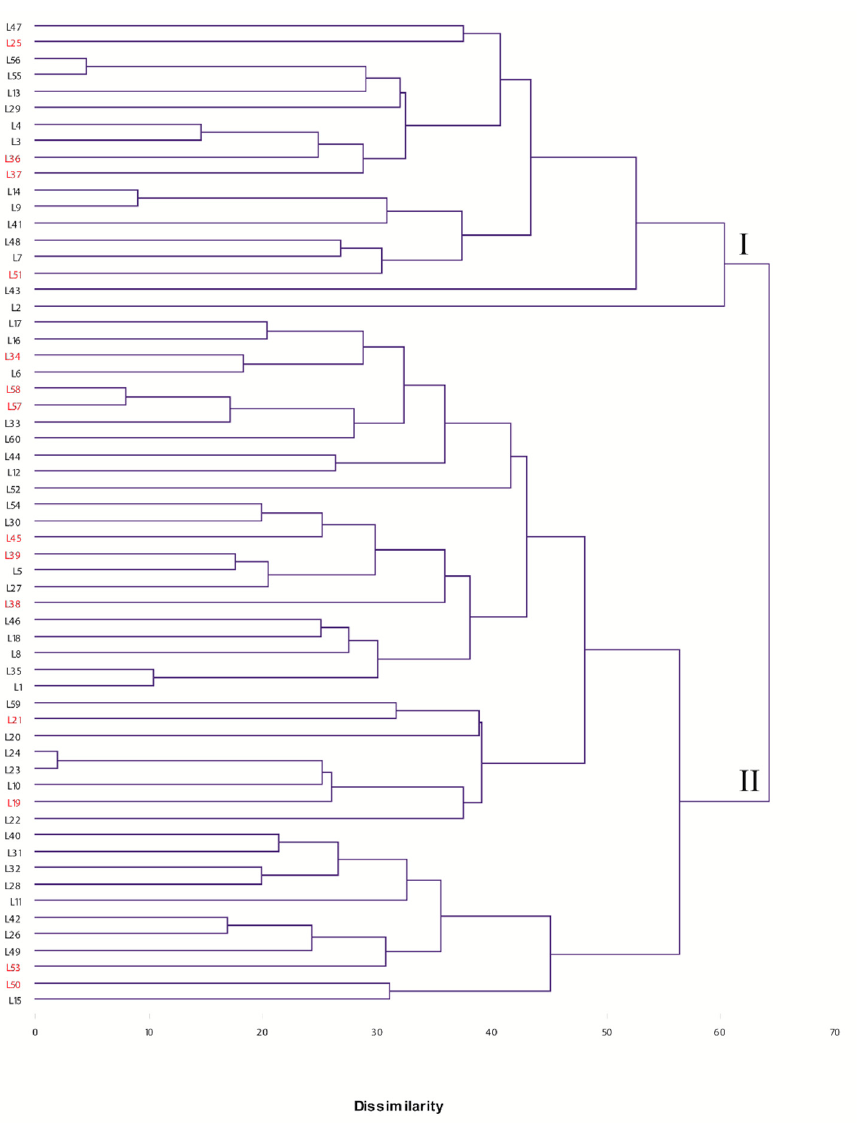
Figure 1. Dendrogram of 60 individual wild hops revealed by UPGMA cluster analysis based Euclidean distance, determined using 8 SSR markers. In red, Trentino Alto Adige accessions are highlighted. Table 4. Average content of hop resins and essential oils in dry cones of wild hop accessions. In red, Trentino Alto Adige accessions are